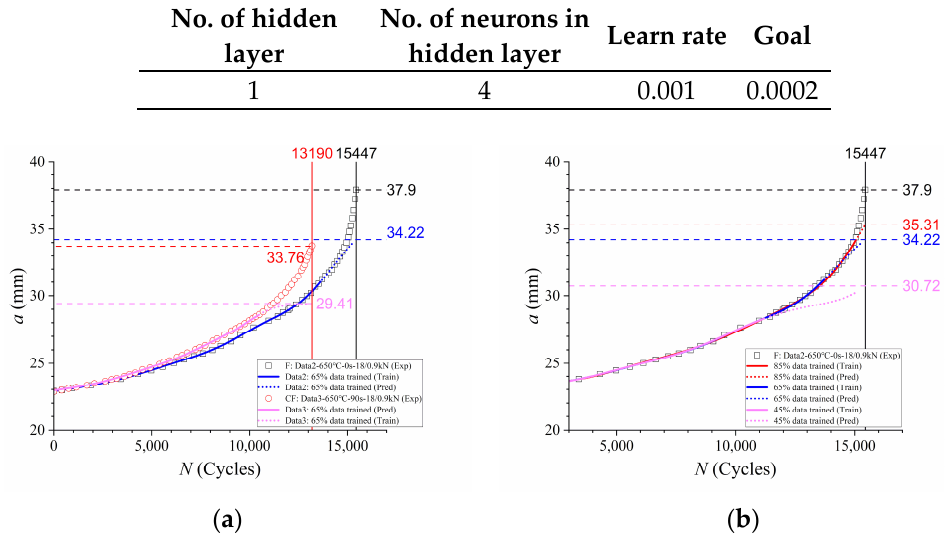
Figure 10. Prediction of a-N curves using basic scheme (RNN) for ( a ) Data2 and Data3, respectively; ( b ) Data2 with various of trained data percentage.